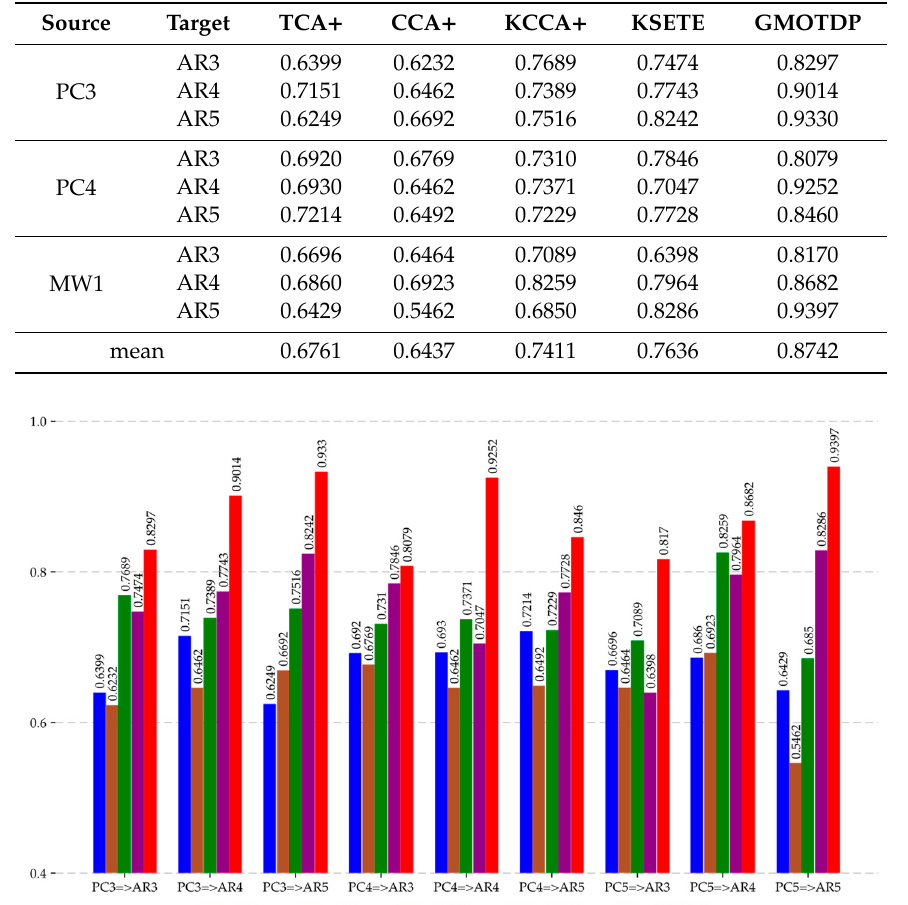
Figure 5. Boxplot for source and target projects with common features using different methods.